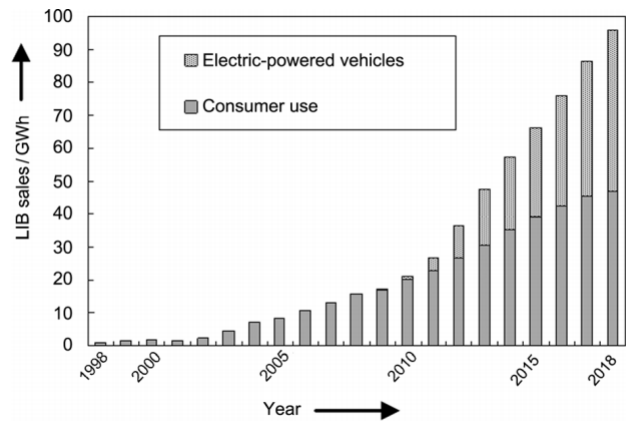
Figure 1. Anticipated growth in the need for lithium-ion batteries. GWh: gigawatt hours. Reprinted with permission from Ref. [1]. 2022, Angewandte Chemie International Edition.